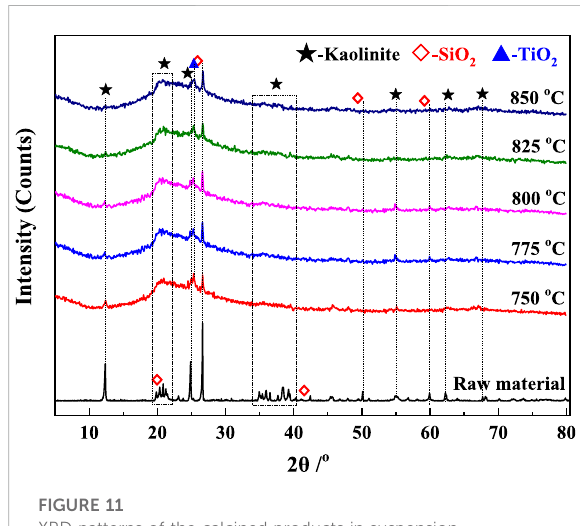
FIGURE 11 XRD patterns of the calcined products in suspension.